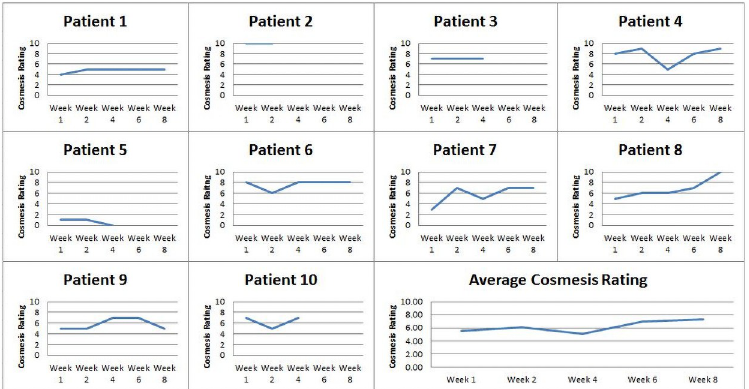
Fig 5. Individual and group cosmesis rating (0–10) by time point (weeks). Subjects 1,4,5,6,7,8,9 completed 8 weeks FU. Subject 2 dropped out at week 4 FU. Subjects 3, 10 received cranioplasties prior to week 8 FU. Subject 5, institutionalized after week 2 FU had no assistance to don HPPD. The average wearing time was computed based on complete data available (N =